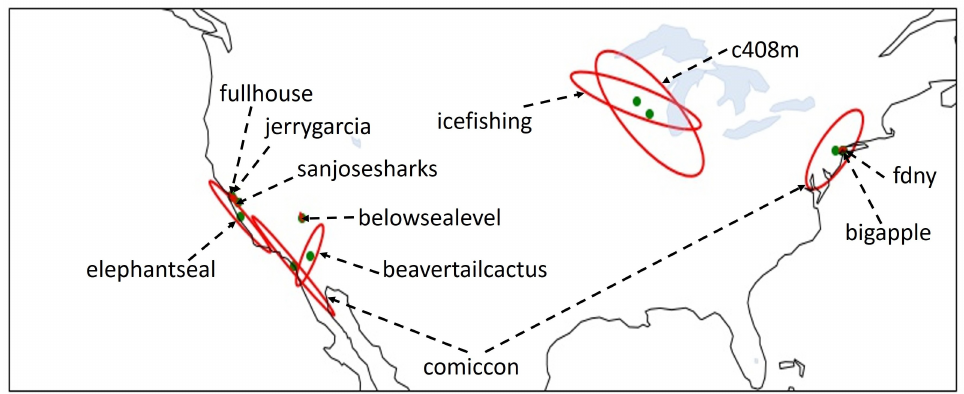
Figure 8. Examples of extracted geospatial concepts which are not in GeoNames and their locations (means and covariance matrices) obtained as the geospatial